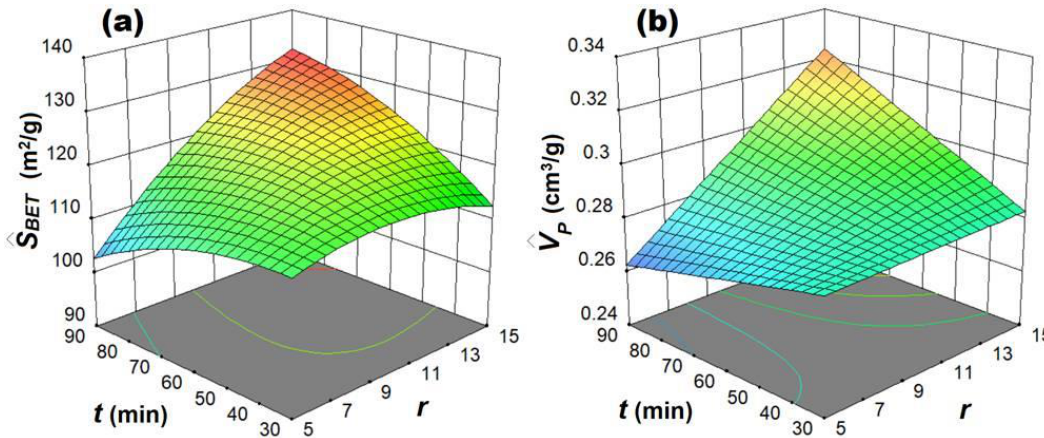
Figure 2. Surface plots of the responses derived from materials characterization by N 2 /BET adsorption isotherms: ( a ) BET surface area ( S BET ) depending on the factors ( t and r ); ( b ) volume of pores ( V P ) depending on the factors ( t and r ).